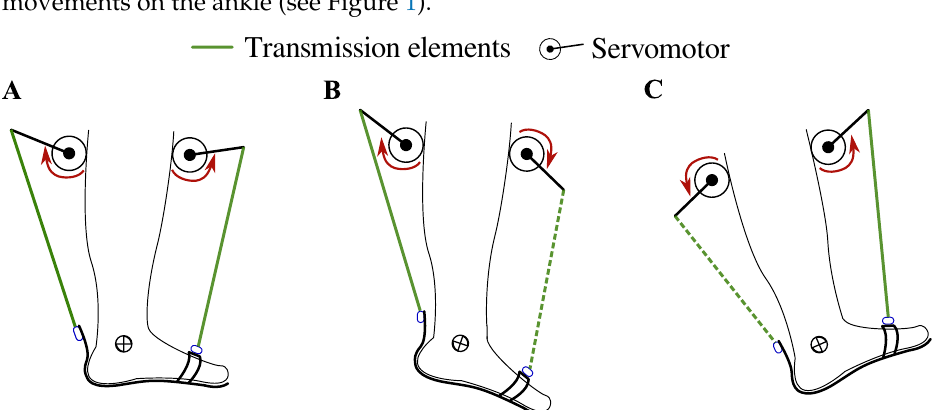
Figure 1. T-FLEX’s actuation system states for gait assistance. The red arrows indicate the actuator direction of rotation to assist ( A ) stance phase, ( B ) propulsion during toe-off, ( C ) and foot clearance in swing and heel strike phases. The segmented and continuous lines refer to the transmission elements’ participation in each movement, i.e., in plantarflexion, only the posterior element works, and in dorsiflexion only the frontal element is